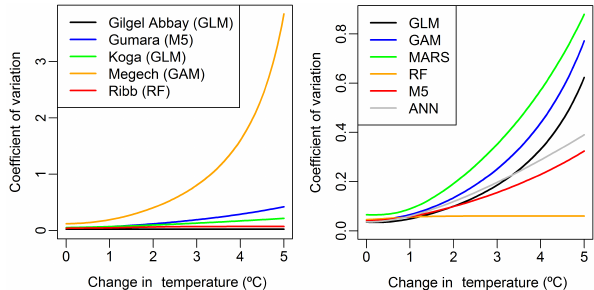
Figure 9. Changes in the coefficient of variation across bootstrap resamples from the highest performing model in each basin (left panel) and multiple models all applied to the Gumara basin (right